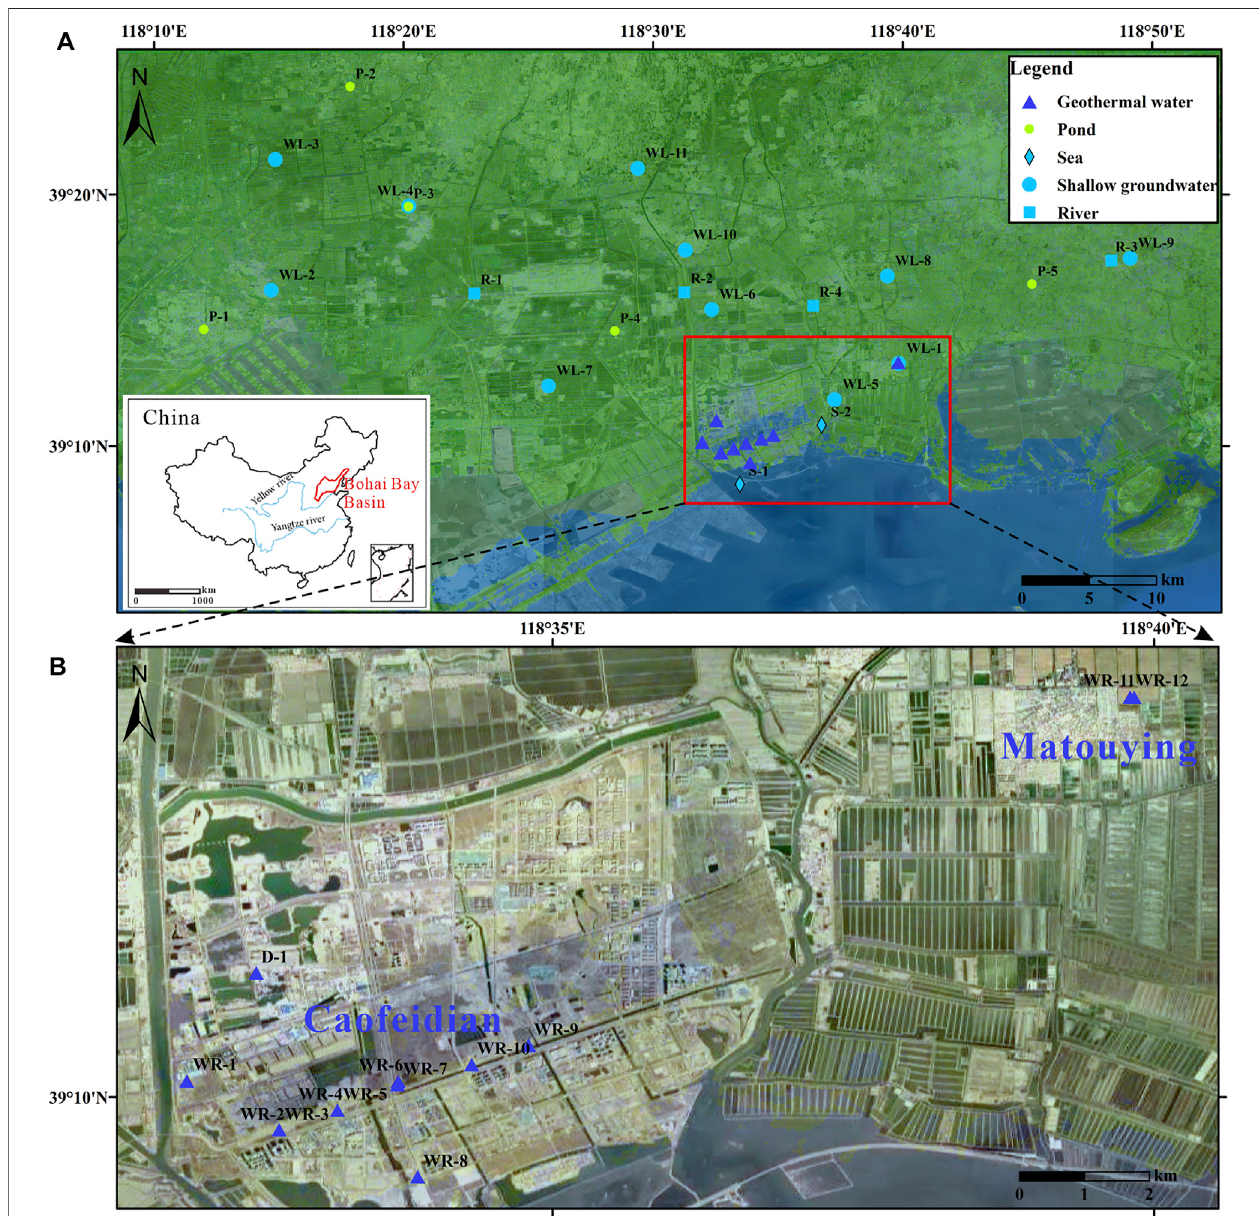
FIGURE1|(A) :LocationofBohaiBayBasininChinaandallthesamplingsitesinthestudyarea,theredrectanglerepresentstheareawherethegeothermal water were sampled; (B) : The sampling locations of geothermal water in the two regions Caofeidian and Matouying.